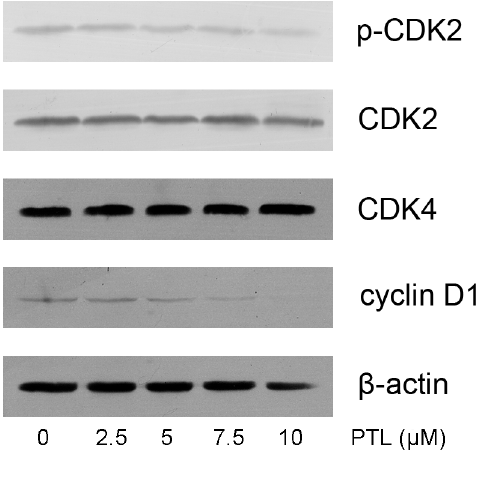
Figure 5. Effects of parthenolide cell cell cycle related proteins in the G1